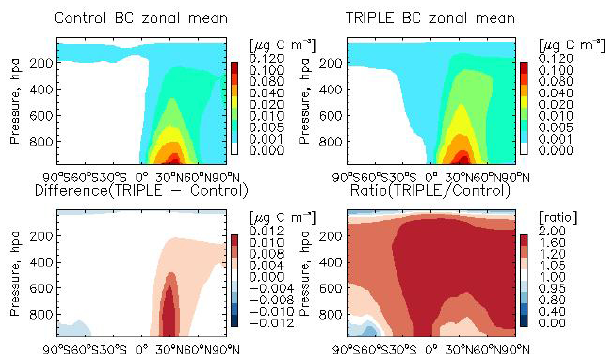
Fig. 11c. Same as Fig. 11a but for zonal mean.